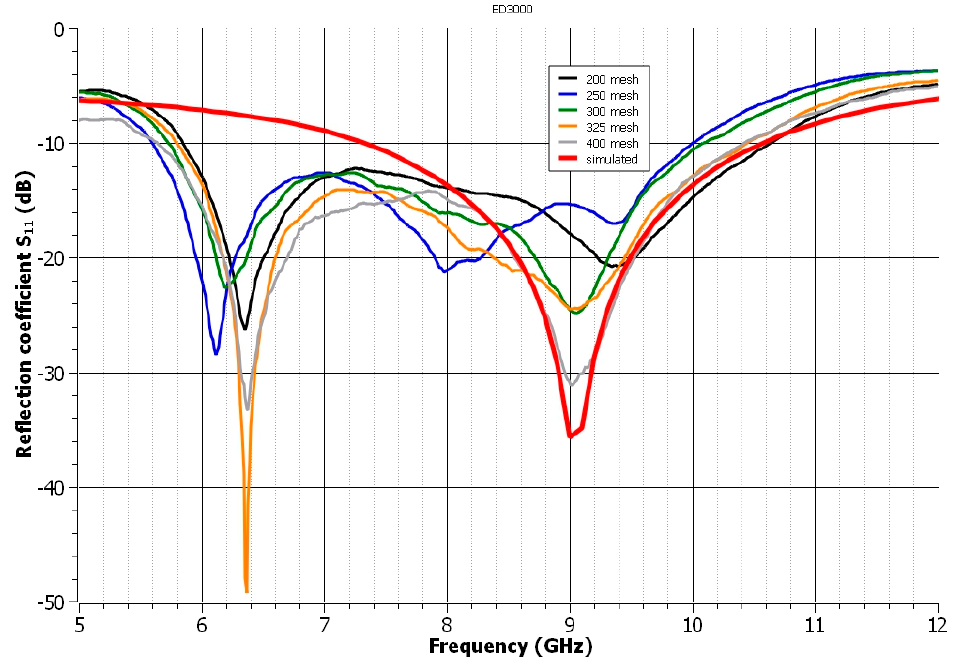
Figure 4. The influence of the mesh of the used screens on the reflection coefficient of antenna— paste ED3000.